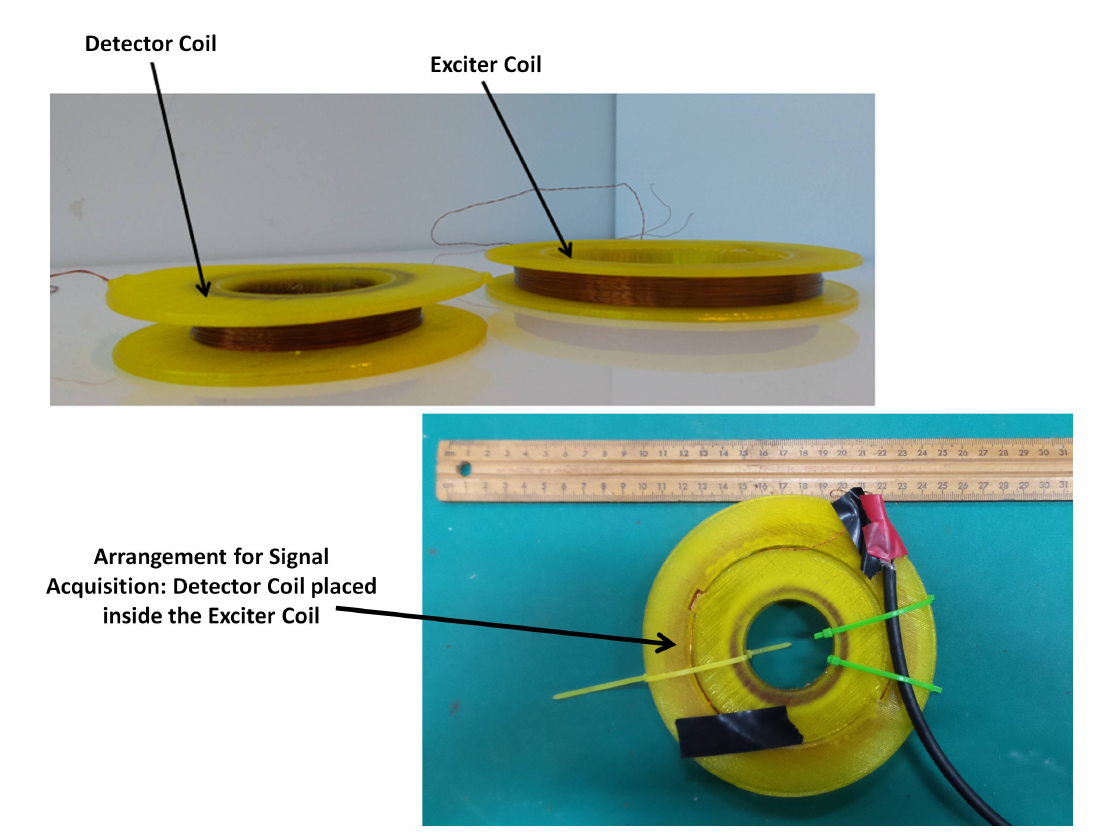
Figure 8. Fabricated PEC